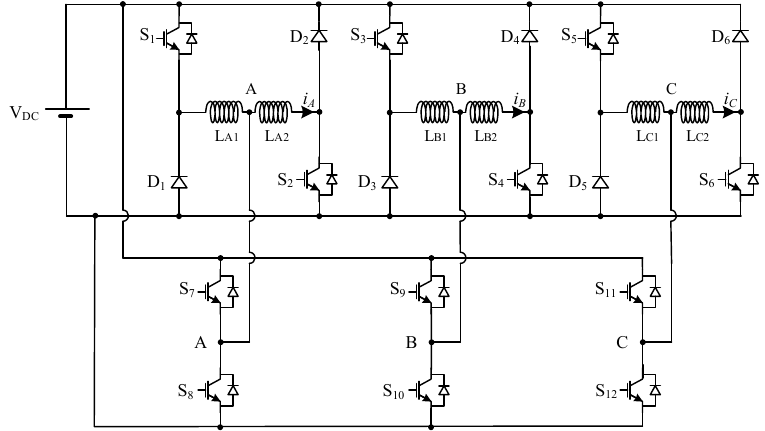
Figure 29. Fault-tolerant topology proposed by [94], combining a classic AHB topology and a classic redundant VSI topology applied to a three-phase SRM.